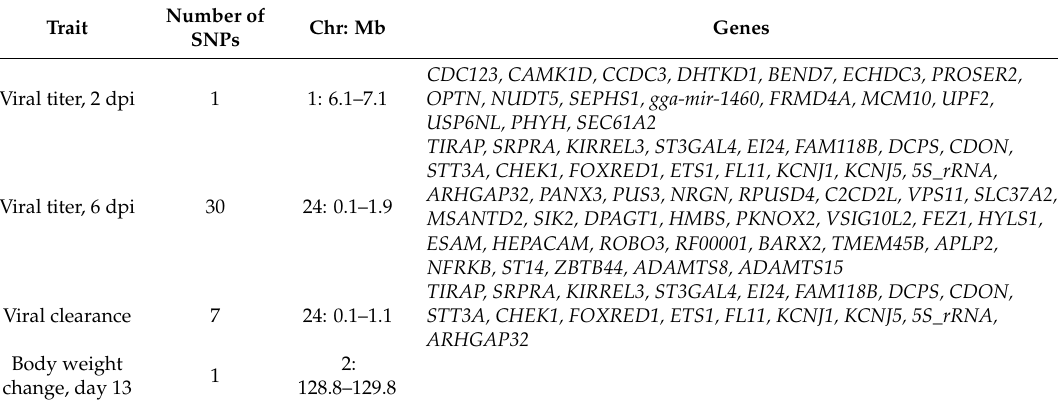
Table 4. QTL region positions and genes located within 1 Mb of the suggestively significant SNPs for the evaluated